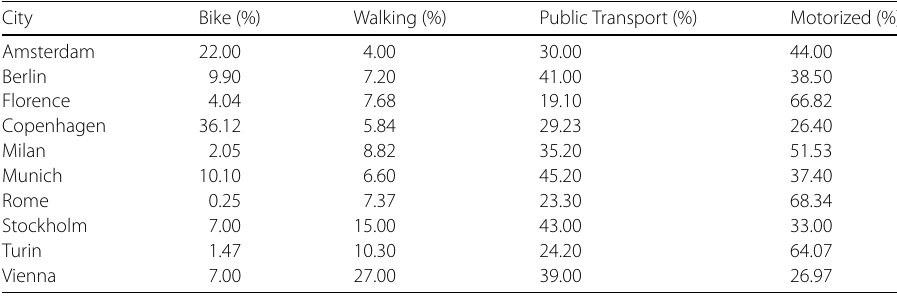
Table 3 Modal share in the 10 cities